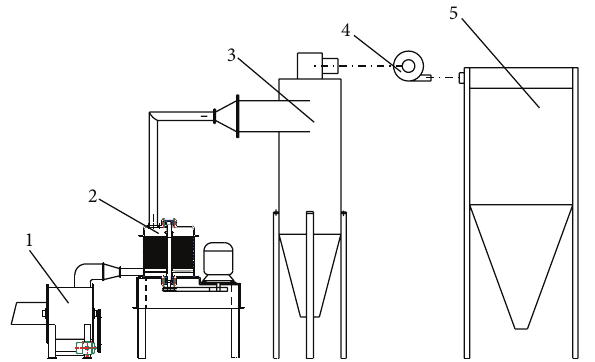
Figure 1: The schematic of the biomass crushing system: 1: primary crusher, 2: advanced crusher, 3: cyclone dust extractor, 4: fan, and 5: bags filter.